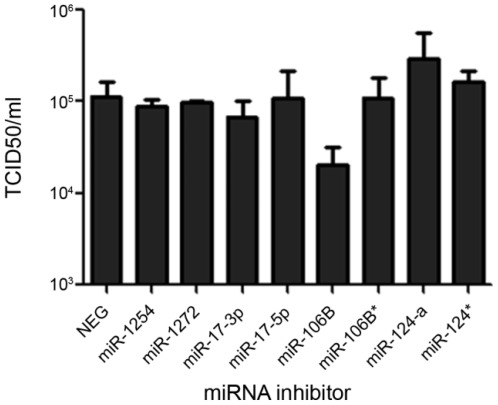
Effect of miRNA inhibition on influenza replication.A549 cells were treated with the appropriate miRNA inhibitor (25 nM) for 48 hours, followed by infection with A/WSN/33 (MOI = 0.001). Cellular supernatant was tested for infectious virus production by a modified TCID50 48 hpi. Data is expressed as TCID50/ml and is representative of two independent experiments.